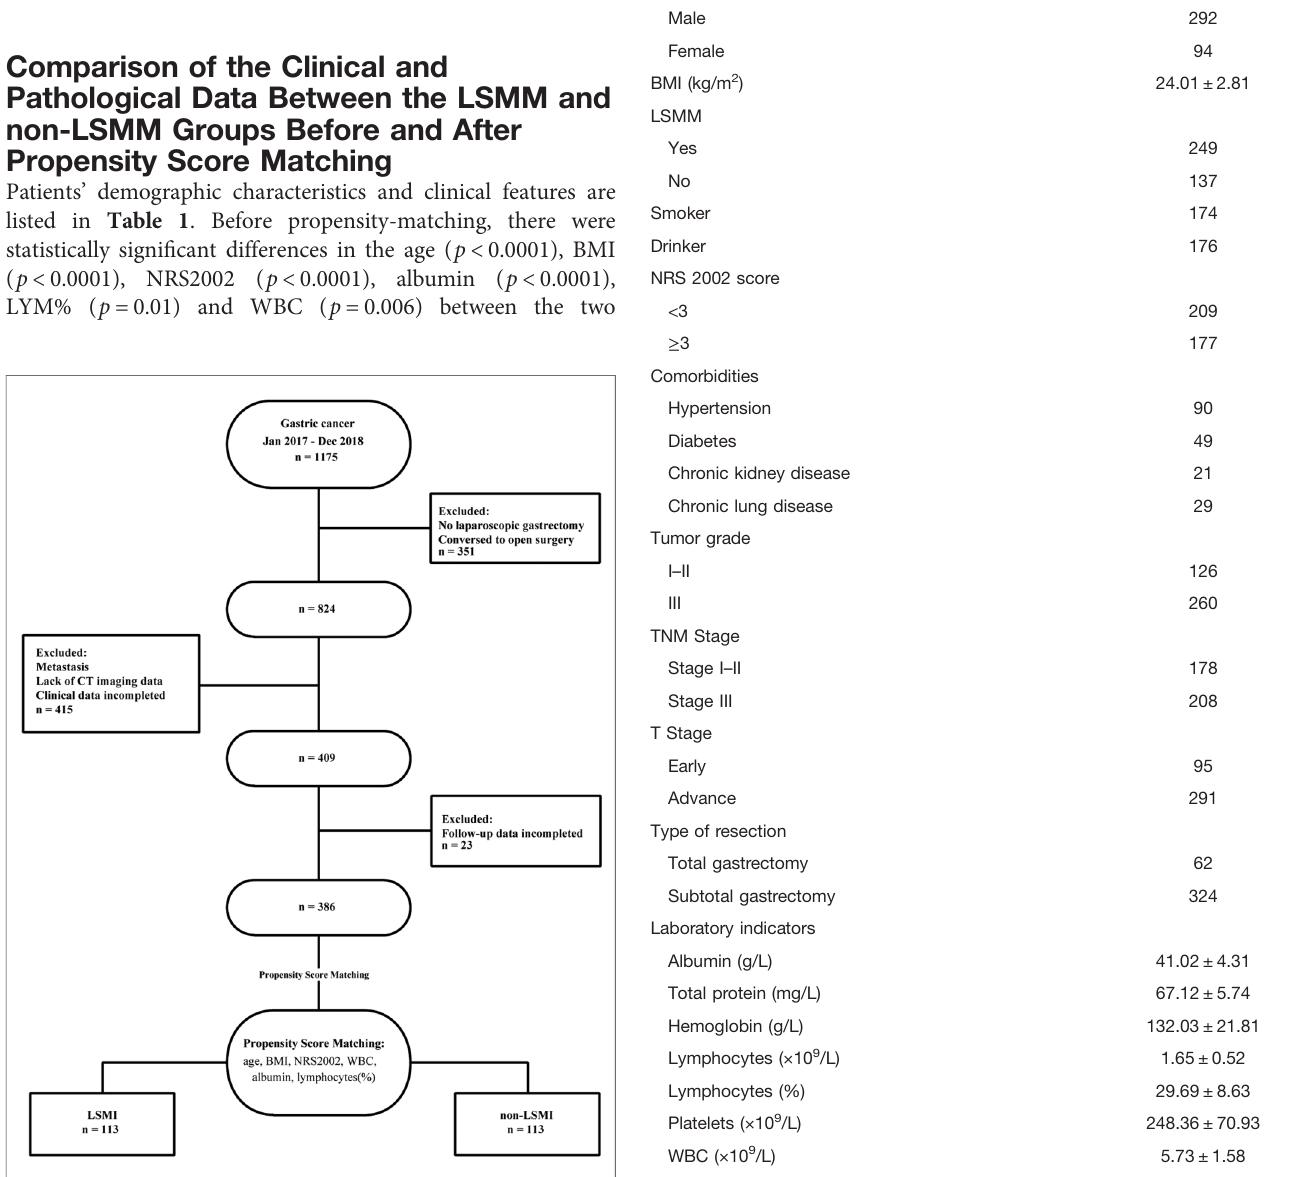
FIGURE 1 | Flow diagram describing the patient matching process.